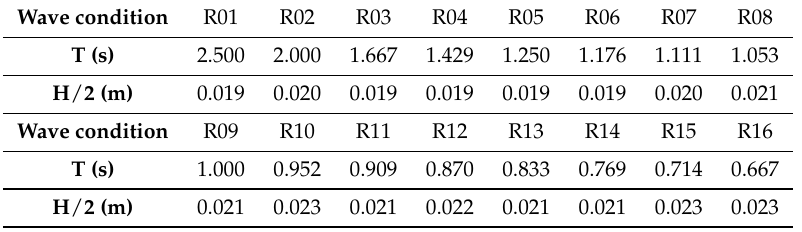
Table 2. Regular waves used for undisturbed waves, fixed WEC and free motion in regular waves experiments. Wave